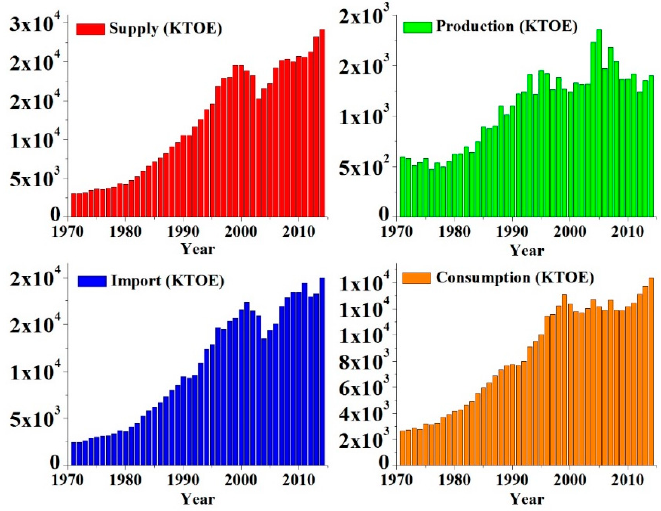
Figure 15. Historical supply, production, consumption and import of oil and petroleum products.